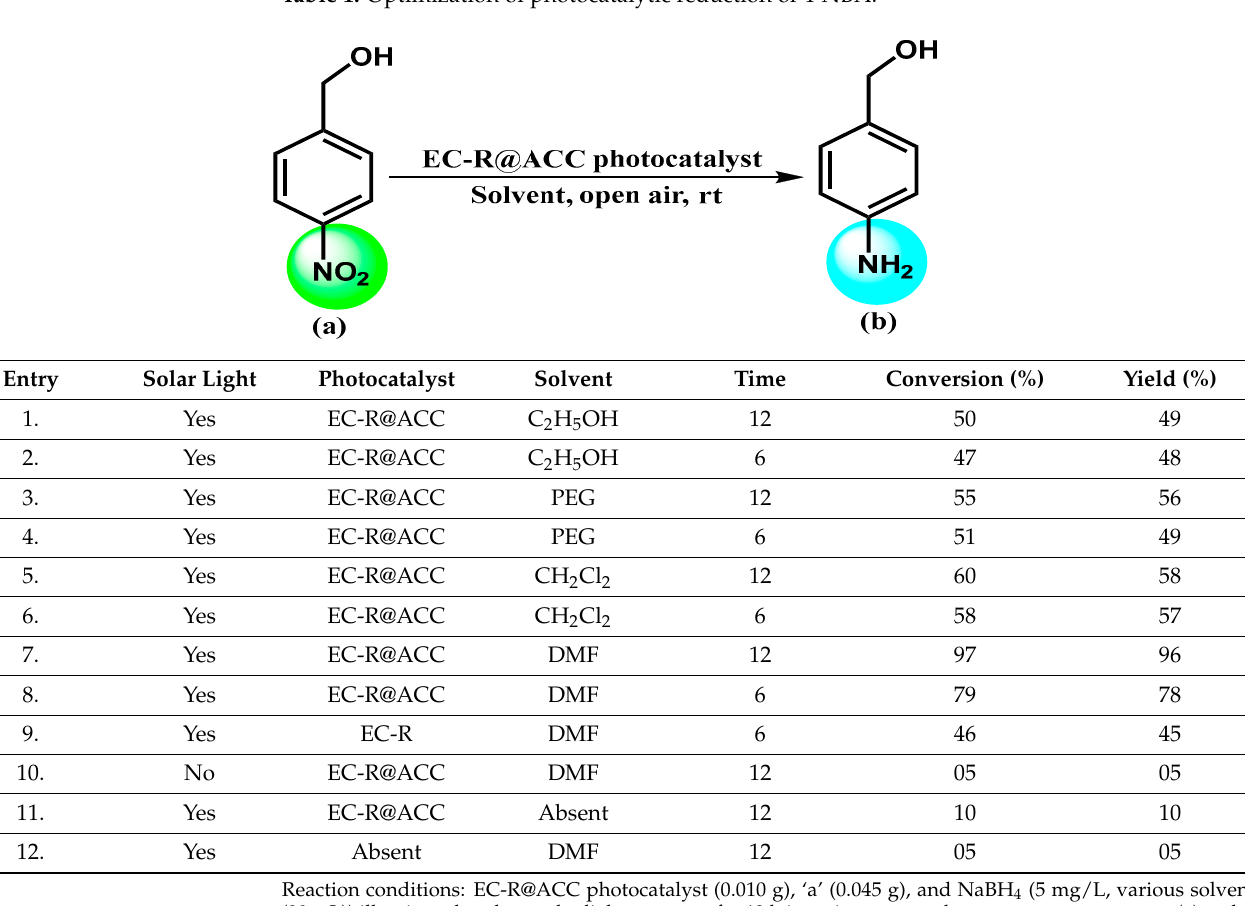
Table 1. Optimization of photocatalytic reduction of 4-NBA.